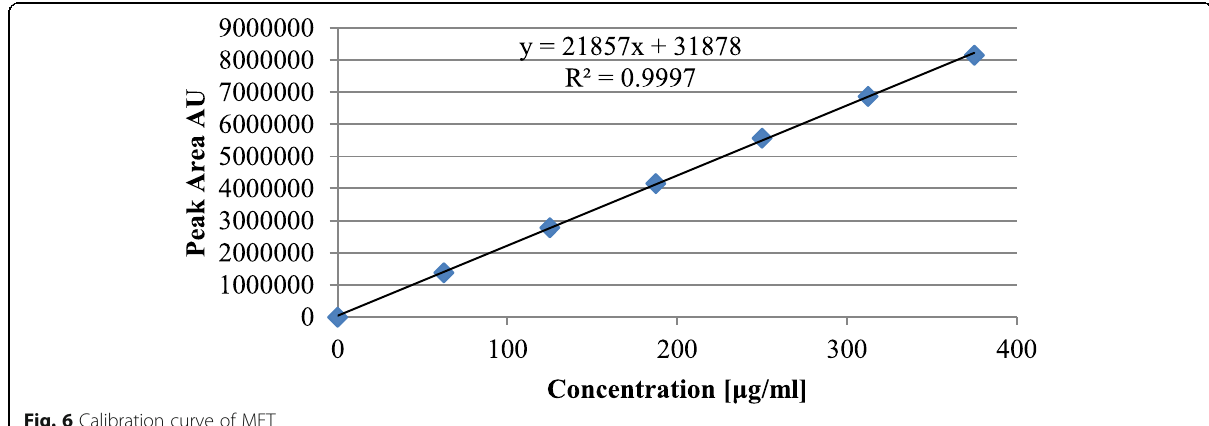
Fig. 6 Calibration curve of